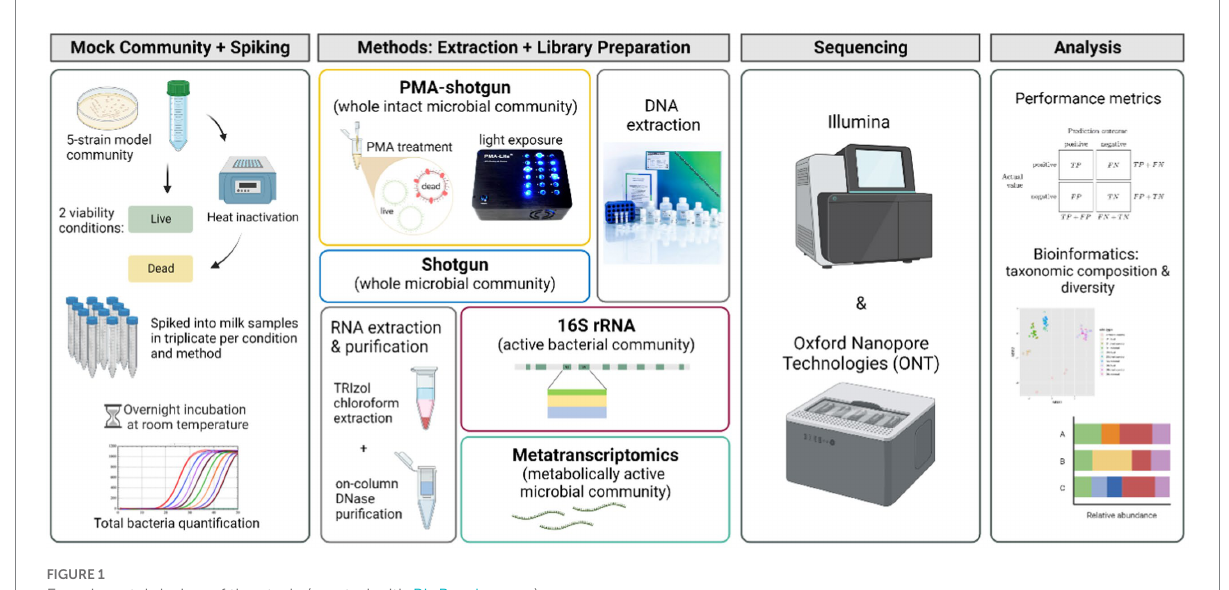
FIGURE 1 Experimental design of the study (created with